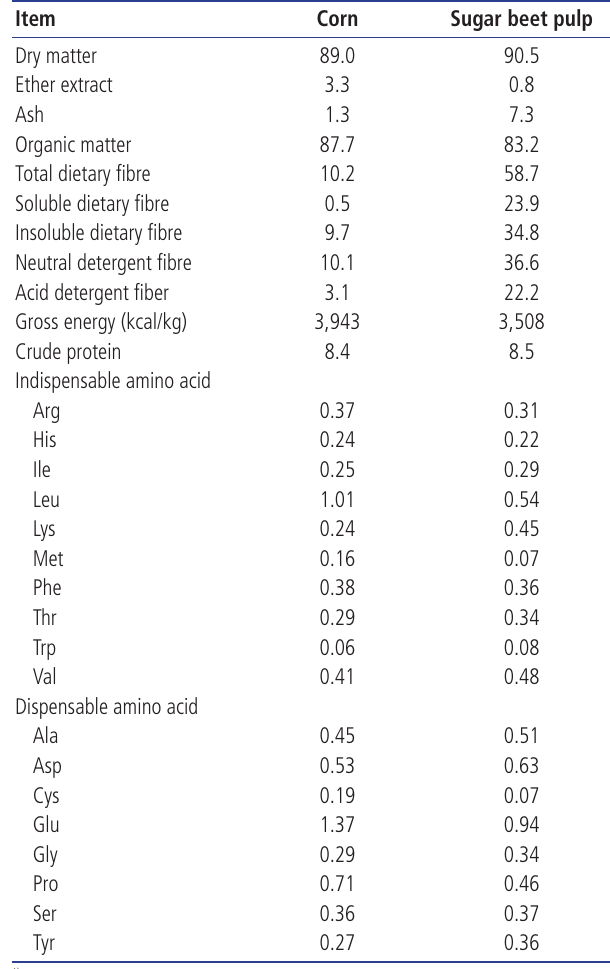
Table 1. Analyzed composition of corn and sugar beet pulp (%, as-fed basis) 1)